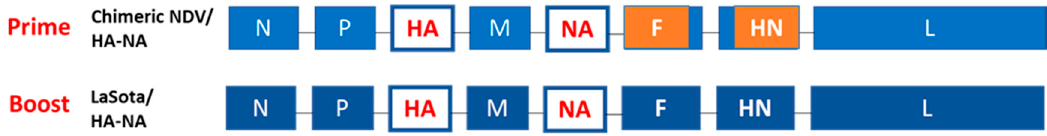
Figure 2. Generation of chimeric NDV- and LaSota-vectored vaccine viruses. The HA and NA genes were placed between the P and M genes and between the M and F genes, respectively. Ectodomains of the F and HN genes derived from APMV-2 are shown as orange rectangles.